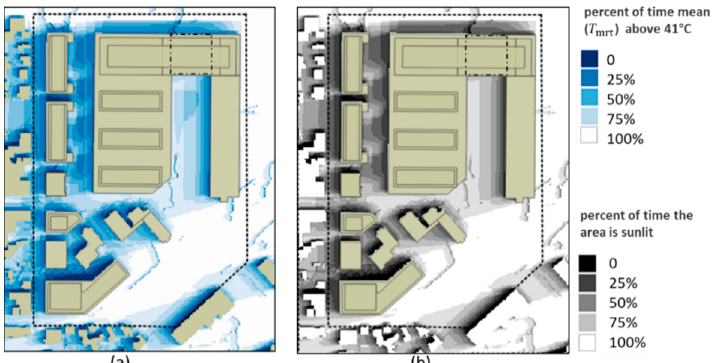
Figure 11. ( a ) The percent of the time that the mean daytime T mrt is above 41 °C during the hottest period of days (12:00–19:00); ( b ) the percent of the time which the area covered sunlit during the hottest period of days (12:00–19:00). Table 3. Thermal sensitivity and grads of physiological stress, according to Mayer and Matzaraki [44].